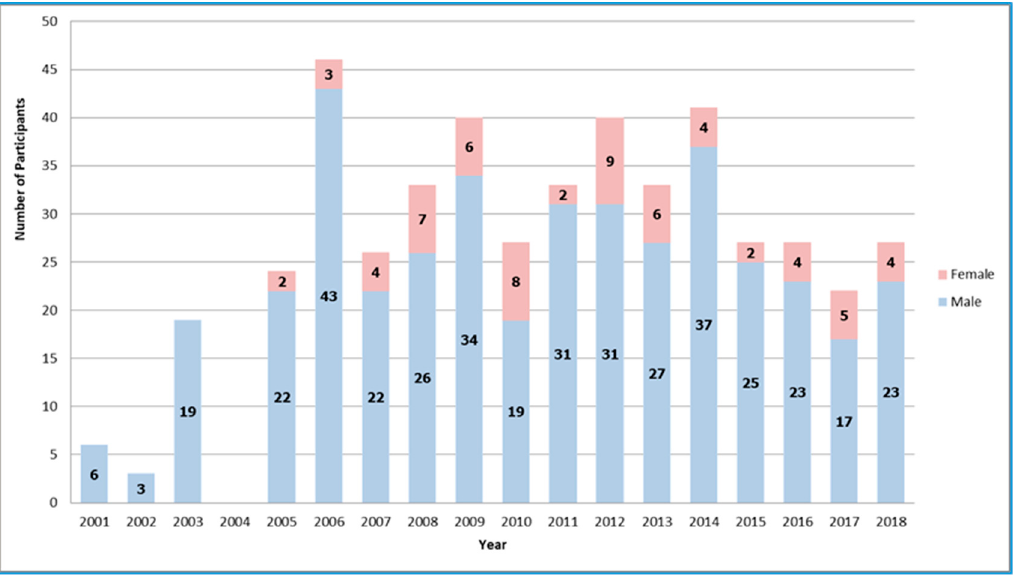
Figure 2. Annual distribution of students in the PGD programme of African Regional Centre for Space Science and Technology Education in English (ARCSSTE ‐ E) from 2001 to 2018. Each bar shows the number of females relative to males.